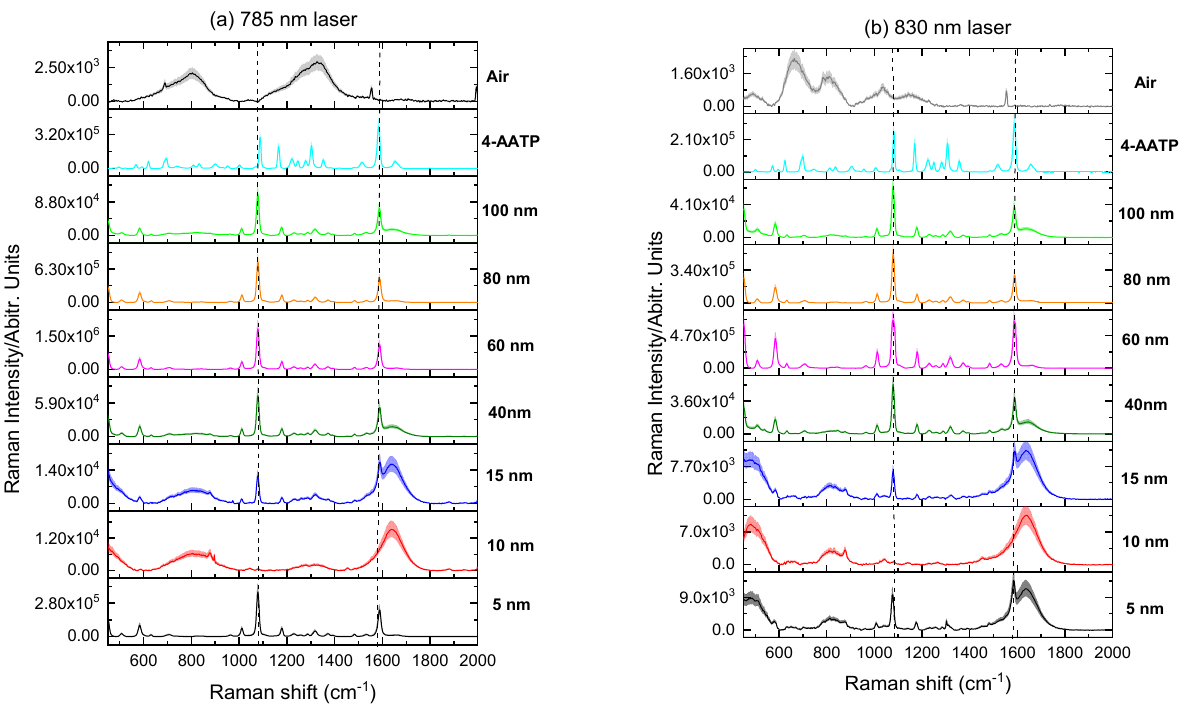
Figure 7. Raman spectra of 4-AATP labeled AuNP solutions measured at ( a ) 785 nm and ( b ) 830 nm.